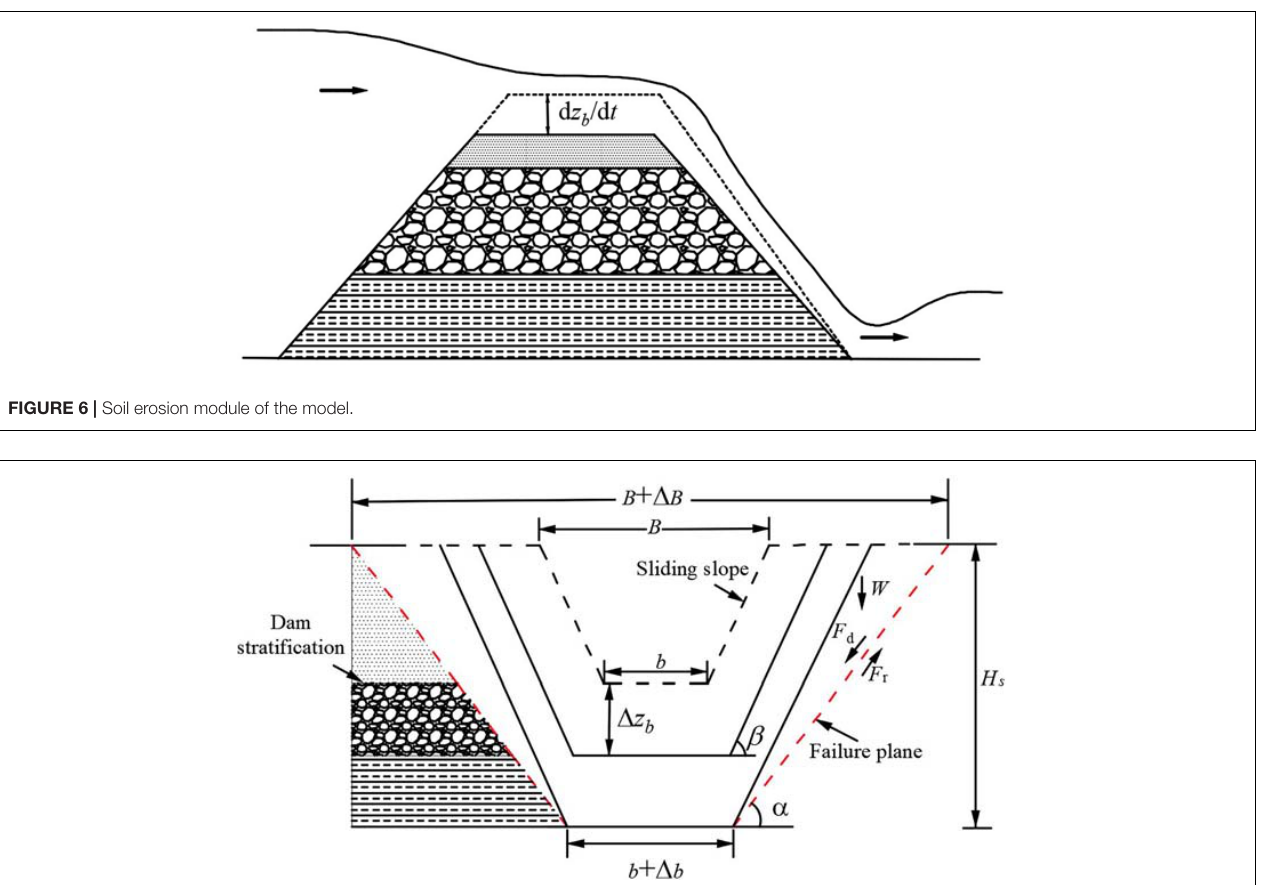
FIGURE 7 | Breach evolution module of the